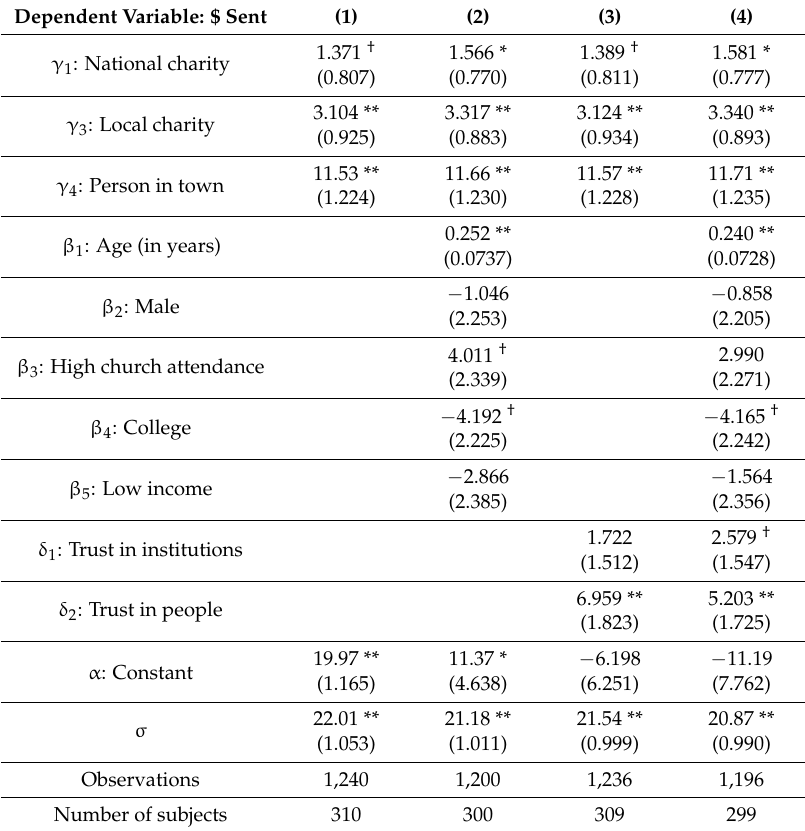
Table 4. Tobit results for comparative dictator game: full sample.